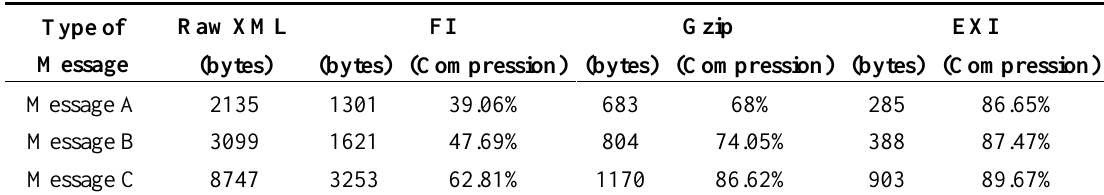
Table 2. Message sizes and percentage of compression for semantically annotated observations in O&M-OWL using Gzip, FI and